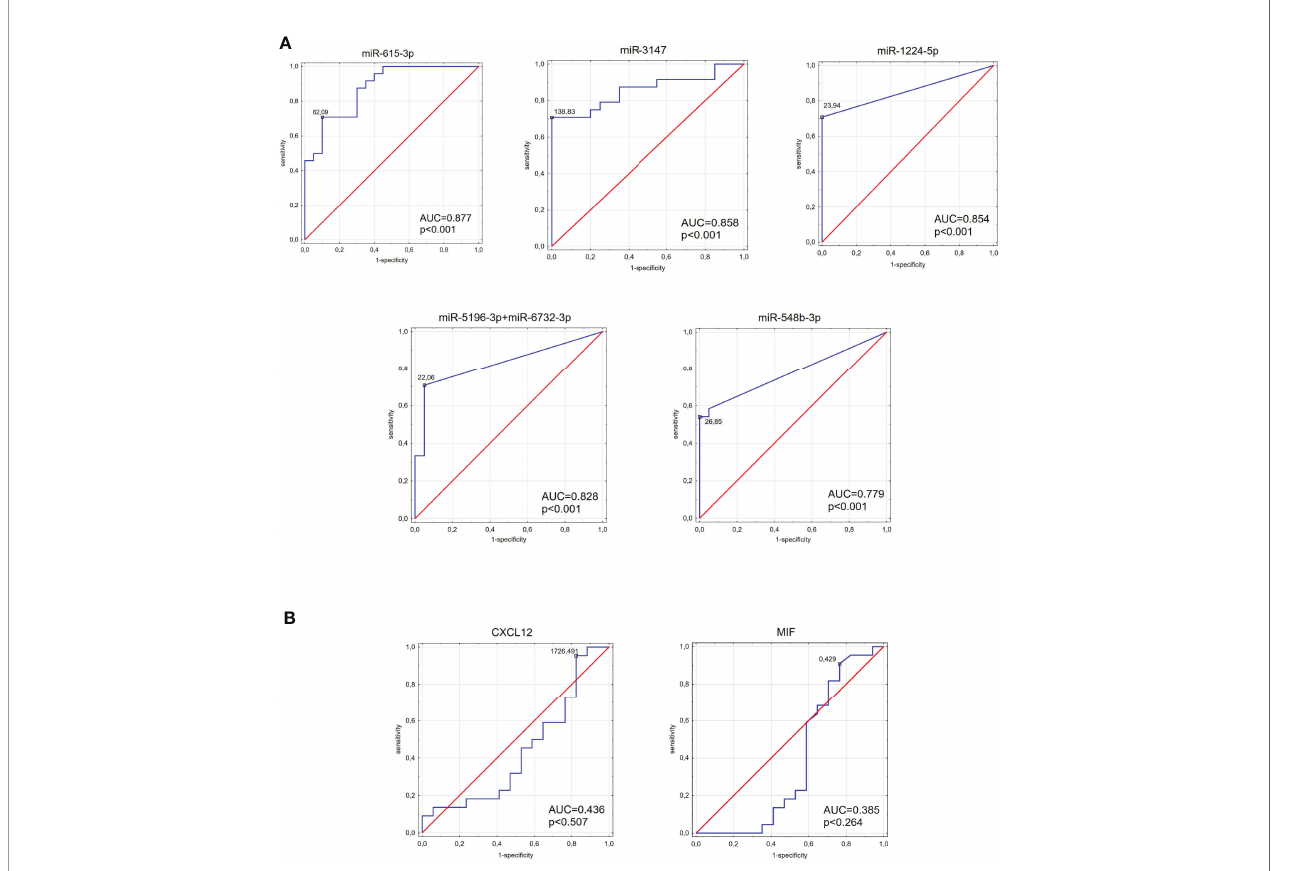
FIGURE 7 | The area under the curve (AUC) of the receiver operating characteristic (ROC) curves for tested miRNAs (A) and MIF and CXCL12 proteins (B) . ROC analysis was carried out to evaluate the diagnostic potential of selected miRNA as a predictive biomarker of type 2 diabetes compared to MIF and CXCL12